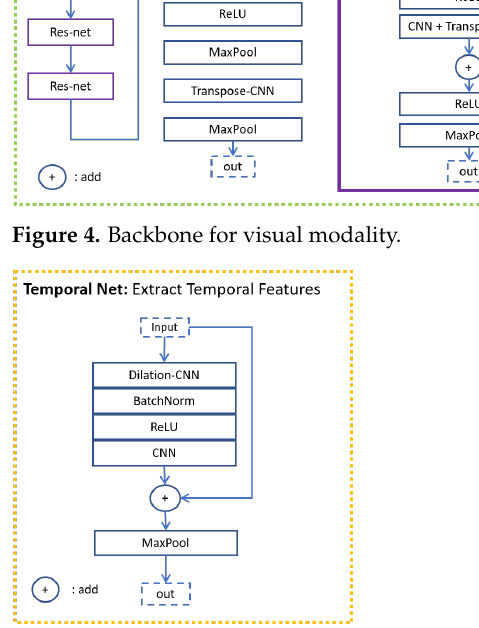
Figure 5. Temporal Net for visual